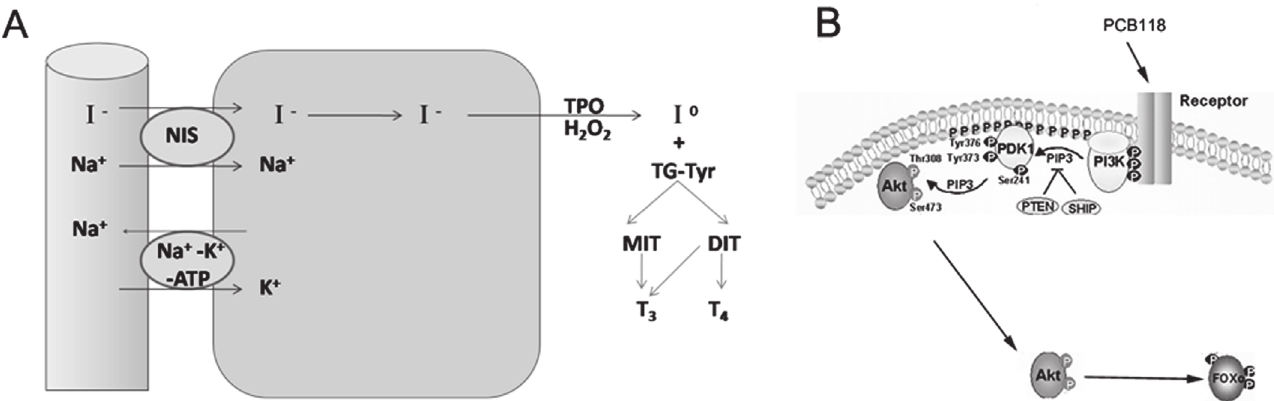
Fig 1. Functional diagrams of NIS and the PI3K/Akt/FoxO3a pathway. NIS is located on the outer membrane of the thyrocyte. Its function is to pump sodium out of the follicular cells while pumping iodide into the follicular cells (A); PCB118 stimulates cells, activates the PI3K/Akt signaling pathway, and increases Akt phosphorylation levels, after which p-Akt phosphorylates its downstream target gene FoxO3a